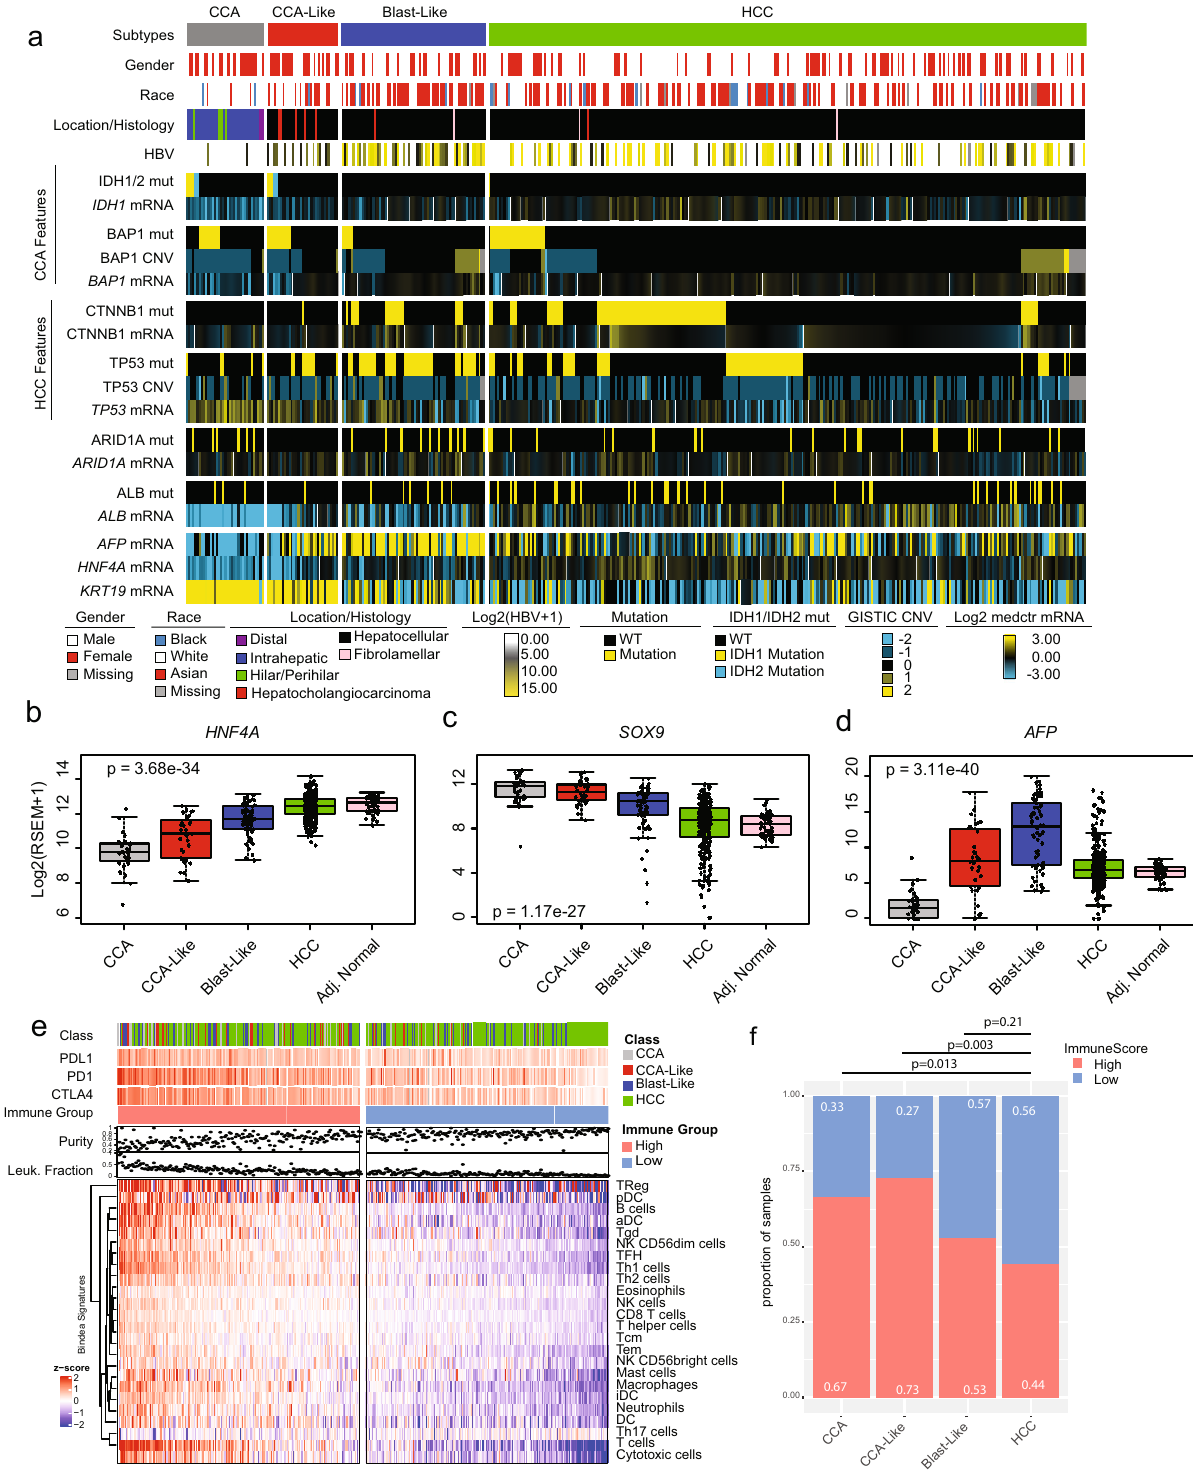
higher expression of the cell cycle and biliary markers but lower expression of hepatocyte markers. CCA had signi fi cantly reduced expression of the hepatocyte marker HNF4A ( p = 1.7e − 10) (Fig. 2b) and ALB ( p = 1.0e − 10) (Supplementary Fig. 4B) and increased expression of cholangiocyte marker SOX9 ( p = 3.6e − 21) as compared to HCC tumors (Fig. 2c). While the CCA-Like were very similar to the CCA tumors, the CCA-Like cells